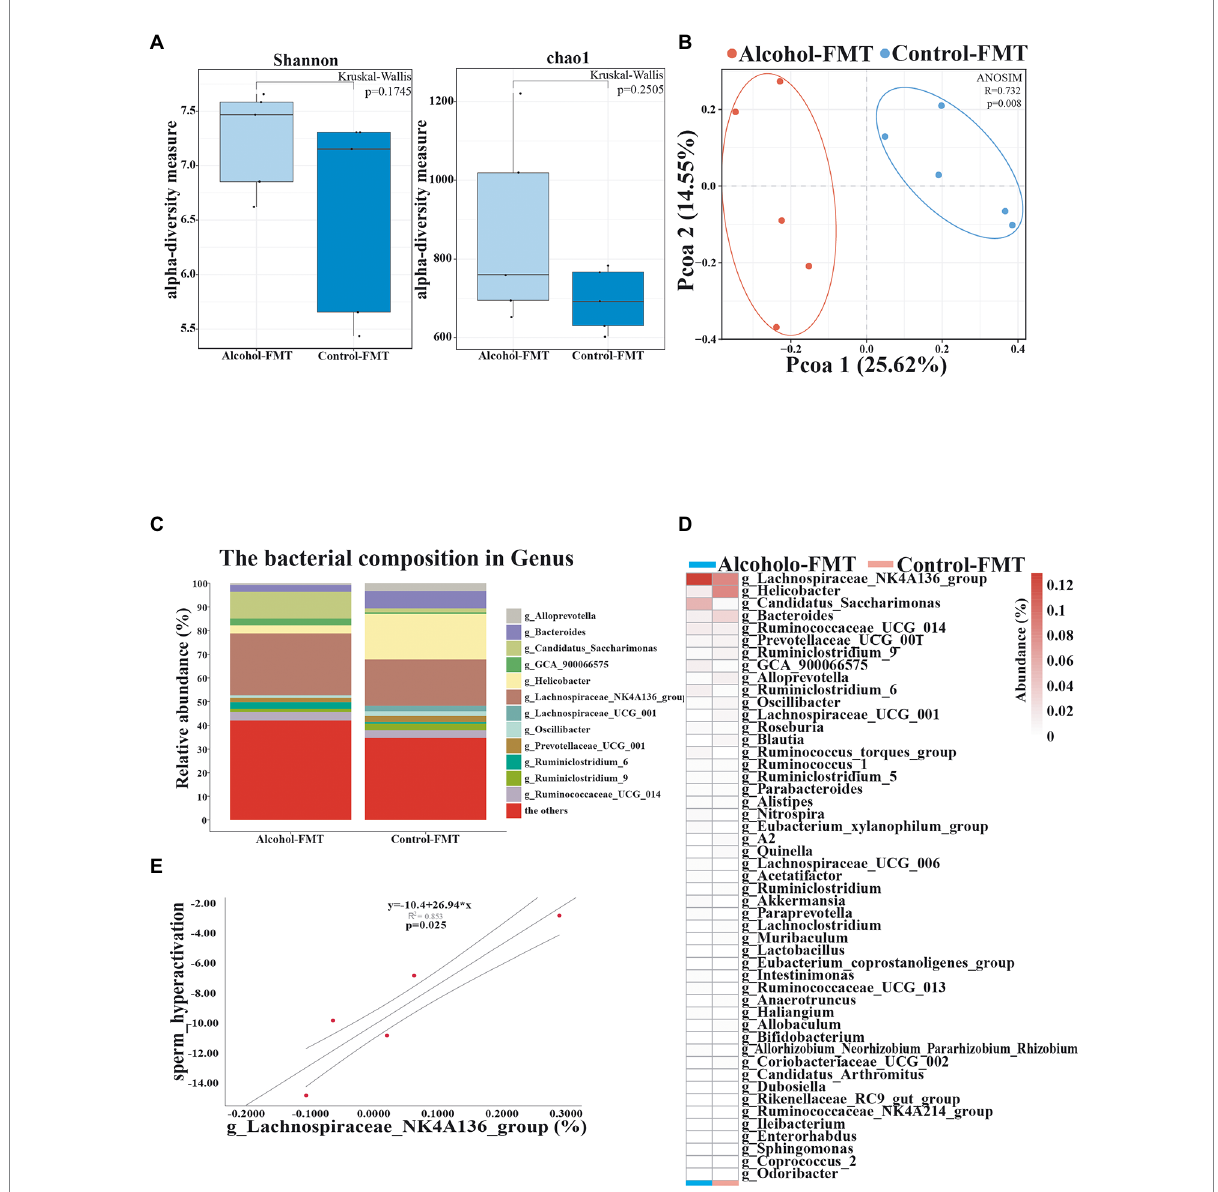
FIGURE 3 Transferring microbiota from alcohol-treated mice alters the gut microbiota community of normal mice. (A) Alpha diversity (based on the Shannon and Chao1 index). (B) PCoA of the beta diversity metric distance. (C) Relative abundance of the indicated genus. (D) Heatmap of selected differentially abundant genera. (E) The correlation between sperm hyperactivation and Lachnospiraceae _NK4A136_group abundance. * p < 0.05 and ** p <